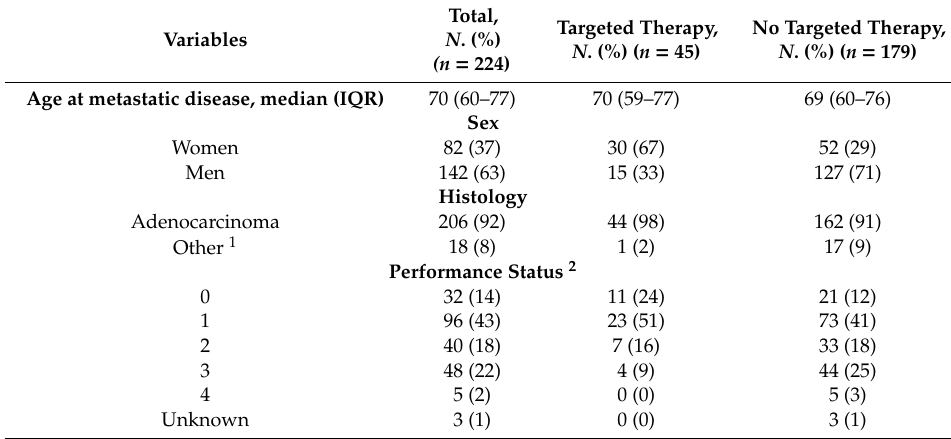
Table 1. Patient Table 1. Patient characteristics.